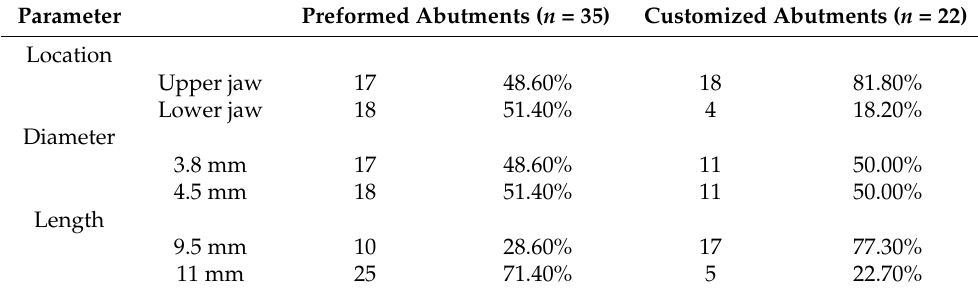
Table 2. Characteristics of the implants.